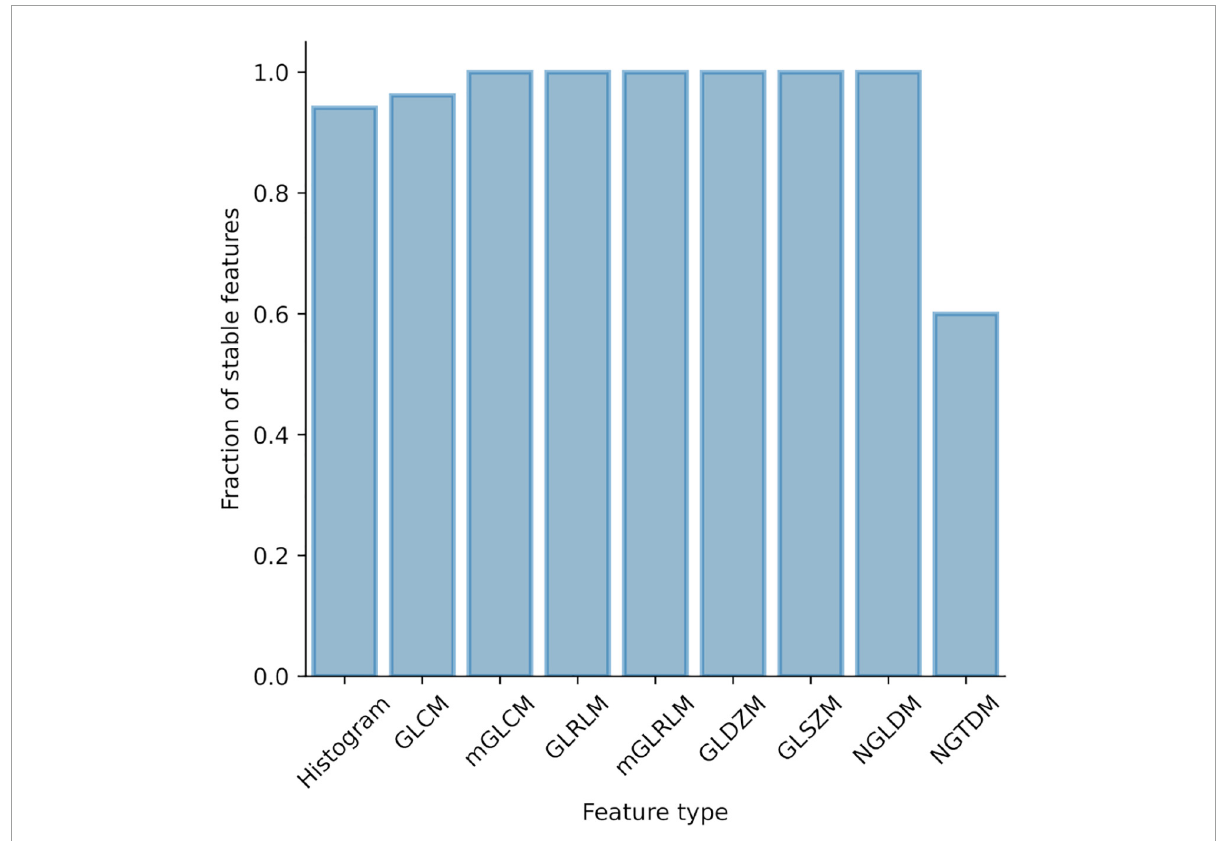
FIGURE3 Influence of intra- and interobserver delineation variability on radiomic features stability. Proportion of unstable features stratified by feature